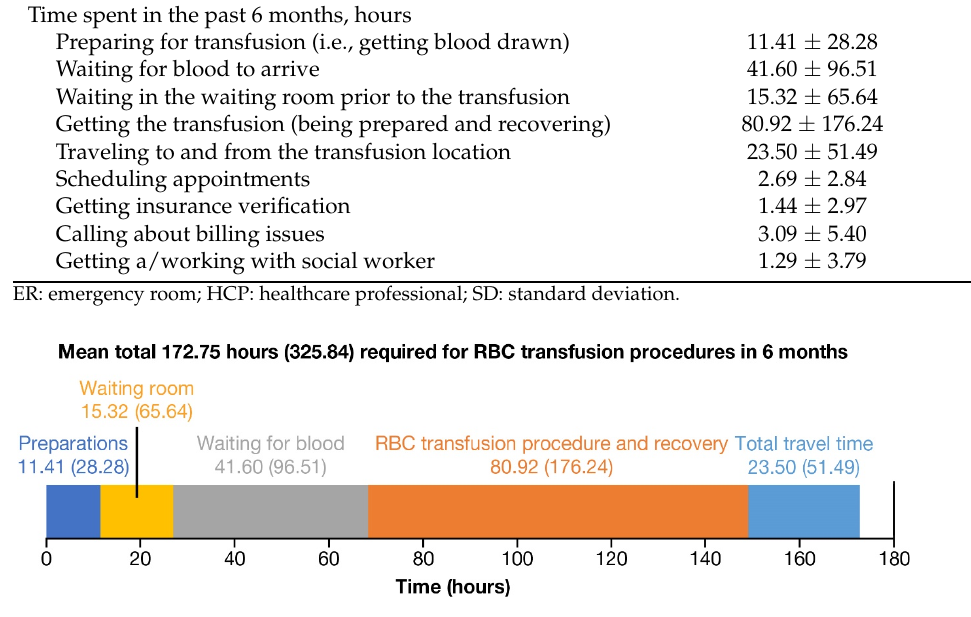
Figure 2. Mean (SD) hours spent for transfusion sessions over a 6-month period. RBC: red blood cell; SD: standard deviation.